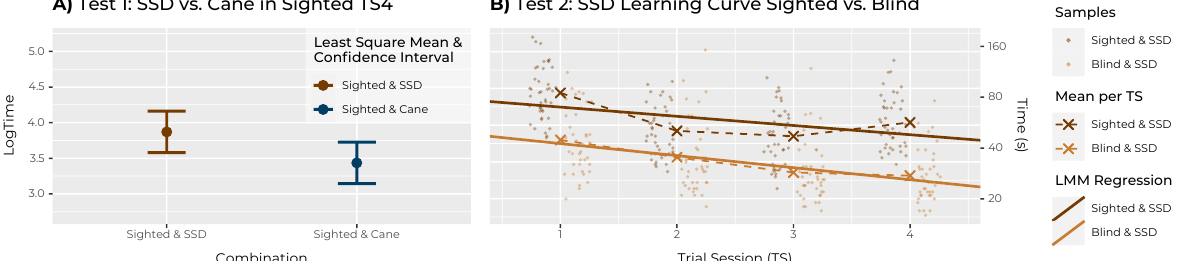
Figure 7. Graphical representations of the two main hypothesis tests. ( A ) Sub-hypothesis H1a: performance with the two devices (SSD/cane) after the last training (only Trial Session 4). Least square means and the corresponding confidence interval extracted from the linear mixed model are shown to demonstrate the test. ( B ) Sub-hypothesis H1b: the learning curves with the SSD in both groups (sighted/blind) over the course of the training (all Trial Sessions) are shown. The test only compares the linear regression slopes, but means and the underlying data points are plotted here as